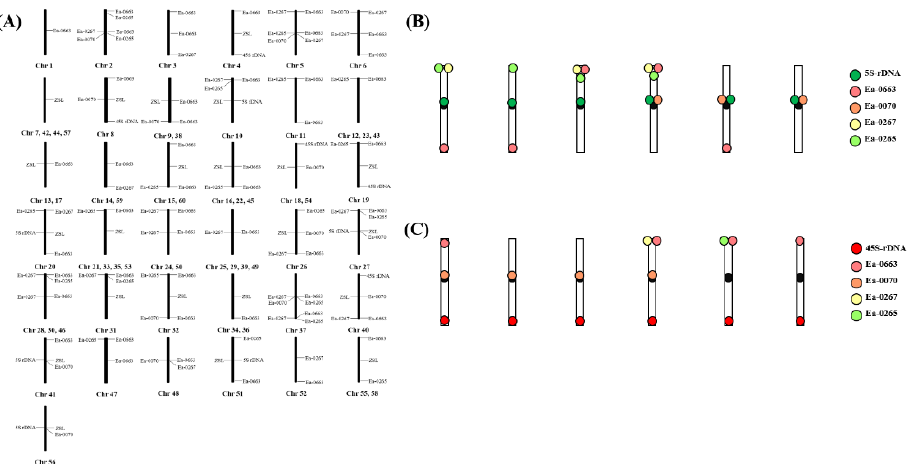
Figure 8. Distribution of the repetitive sequences in different chromosomes of T. arundinaceum . ( A ) The location of seven probes (Ea-0663, 5S rDNA, 45S rDNA, Ea-0267, Eacent, Ea-0070 and Ea-0265) on the chromosomes of T. arundinaceum ; ( B ) The distribution of Ea-0663, Ea-0070, Ea-0267, and Ea-0265 on six homologous chromosomes that carried 5S rDNA loci; ( C ) The distribution of Ea-0663, EA-0070, Ea-0267, and Ea-0265 on six homologous chromosomes that carried 45S rDNA loci.